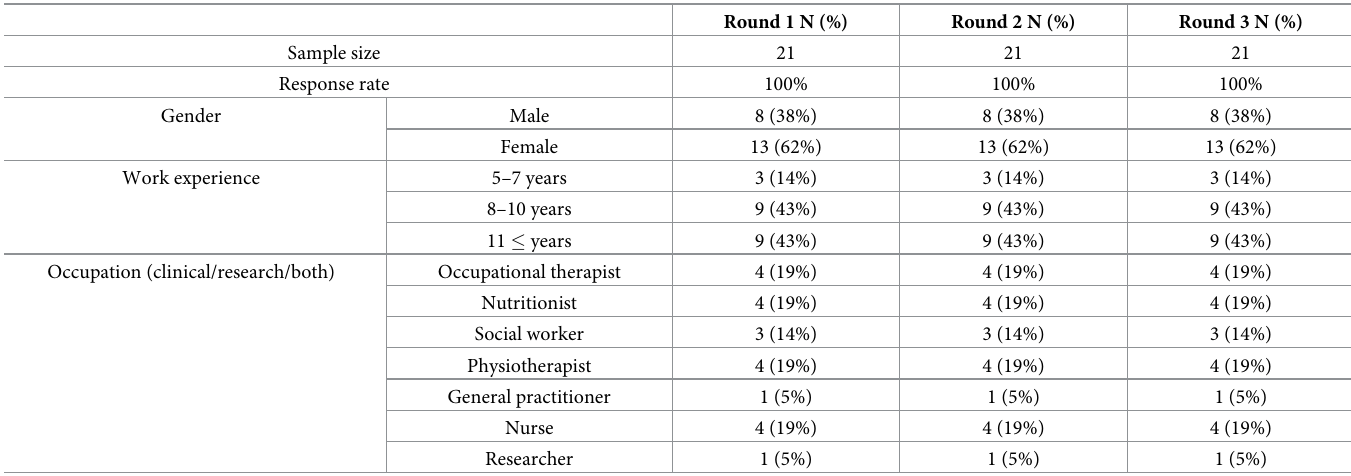
Table 2. Demographic characteristics of the respondents ( n =